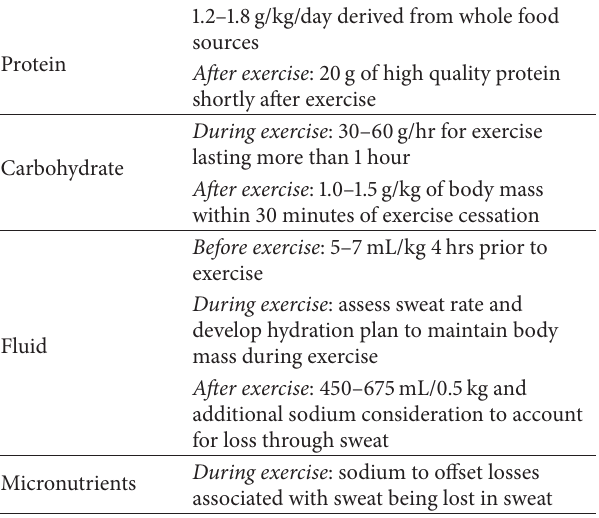
Table 3: Supplemental nutrition recommendations for